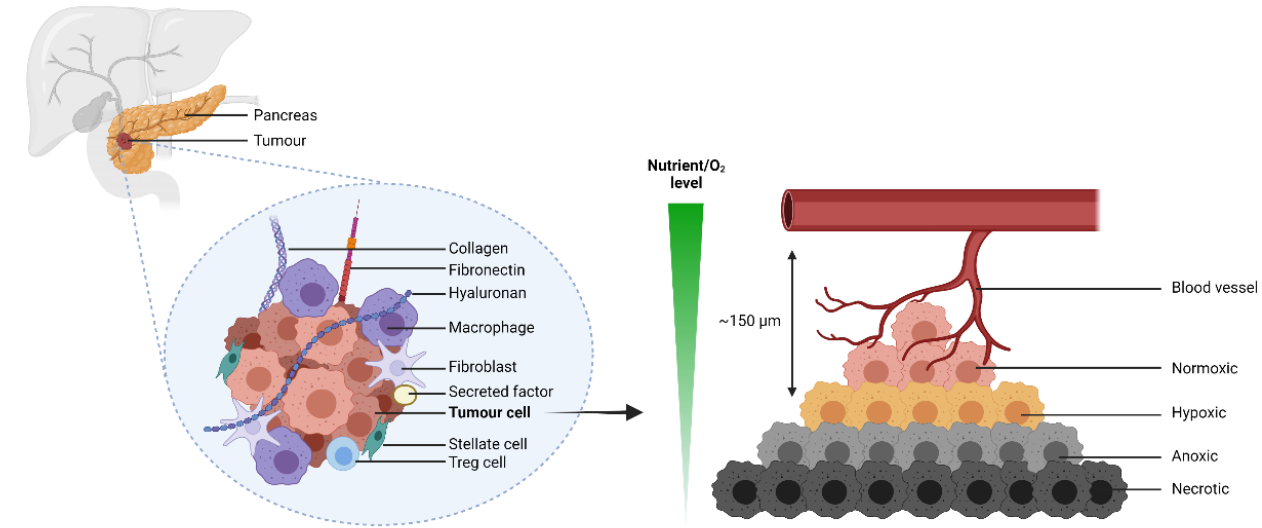
Figure 1. The desmoplastic stromal compartment of PDAC restricts perfusion of its tumor cells. 150 µm is the typical maximal diffusion distance of oxygen from the capillary bed to tissue [ 5,6]. Figure created with BioRender.com.